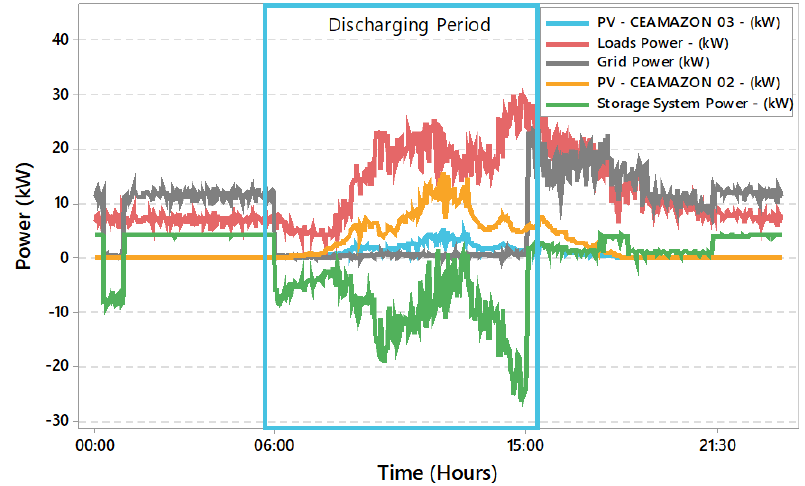
Figure 11. Storage system operation cycle in off-grid conditions.